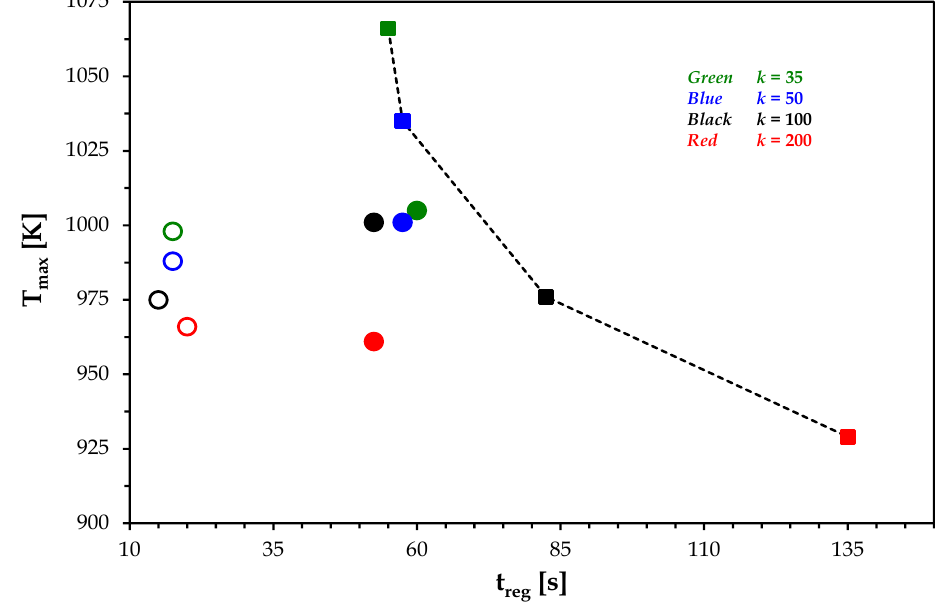
Figure 16. Operating map of the filter in the plane T max versus t reg : results at T in = T in_optimal with (full circles) and without (empty circles) preheating for di ff erent values of k . The lower branch of the curve at V in = 1 m / s of Figure 10 is also